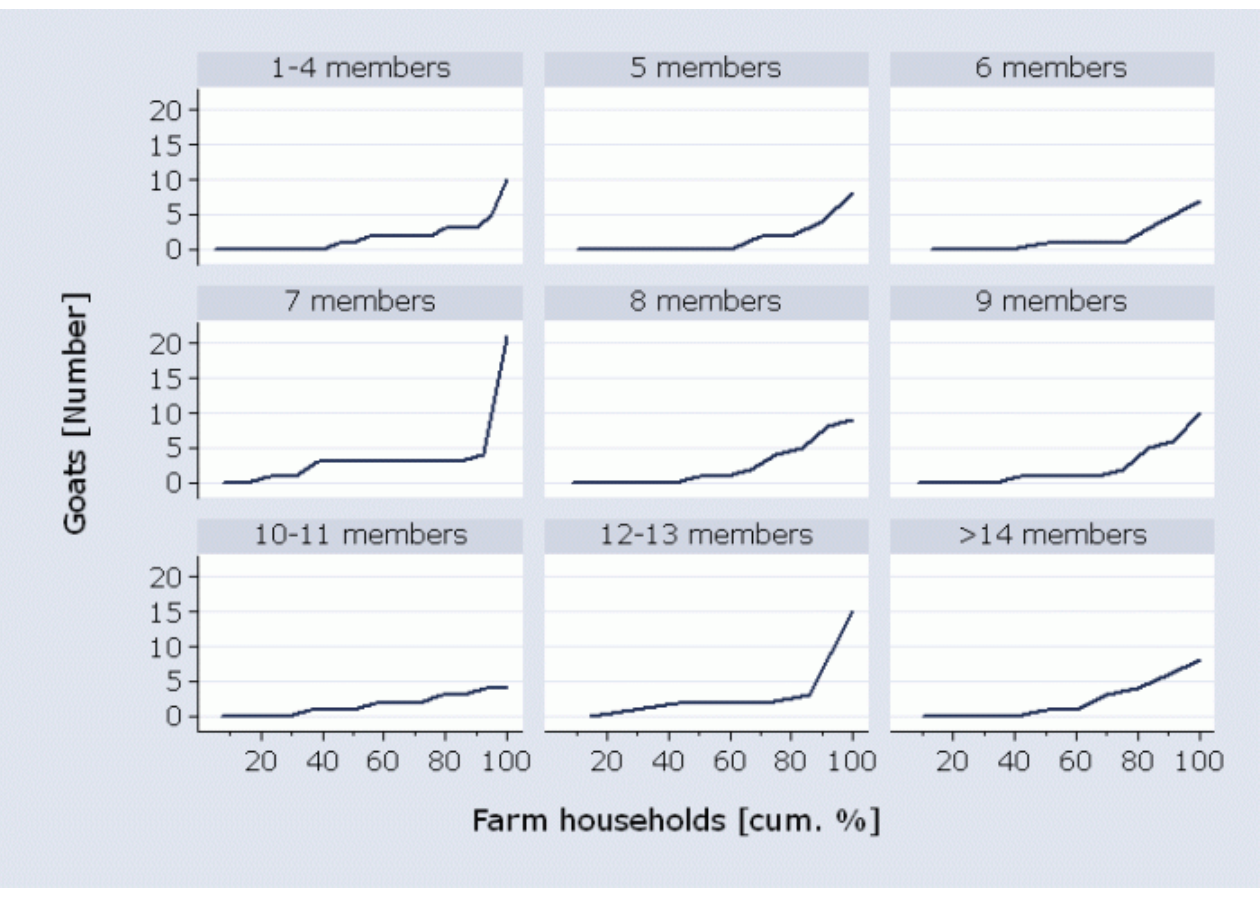
Fig. 4. Empirical cumulative distribution functions of goat numbers over nine clusters by household